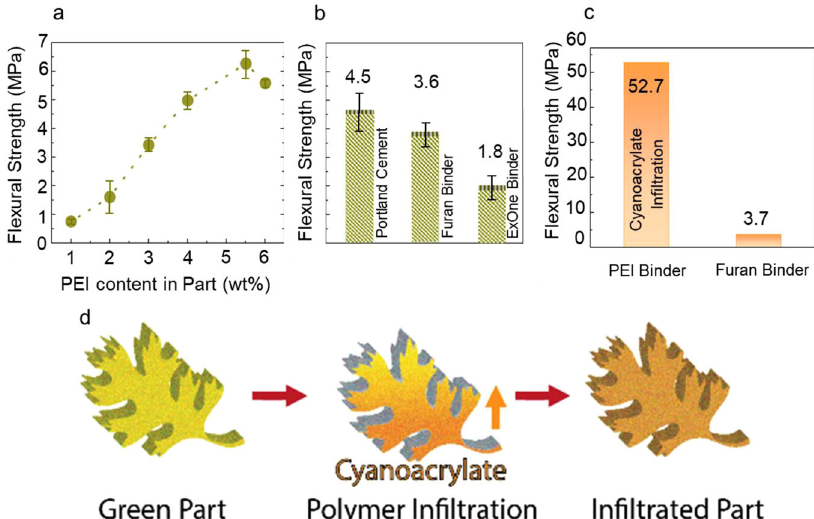
Fig. 2 Mechanical properties of BJAM as printed and in fi ltrated parts comparing PEI with traditional binders and other sand composites. a Flexural strength of green parts printed with 15 wt% PEI binder at varying saturations; every sample iteration was tested in triplicate and the standard deviation was taken to provide the error bars. b Comparison of PEI binder fl exural strength with other commercial binders and cement; All samples were tested in triplicate and the standard deviation was used to calculate error bars. c Flexural strength of ethyl cyanoacrylate (ECA) in fi ltrated green parts comparing PEI binder vs. furan binder. d In fi ltration of green parts with